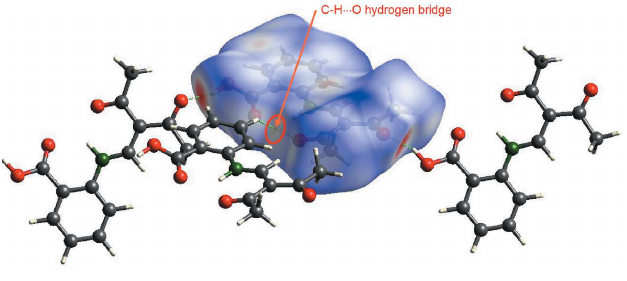
Figure 5 View of the Hirshfeld surface of 1 mapped over d norm in the range (cid:5) 0.712 to 0.973 au showing intermolecular hydrogen bonds as green dashed lines.